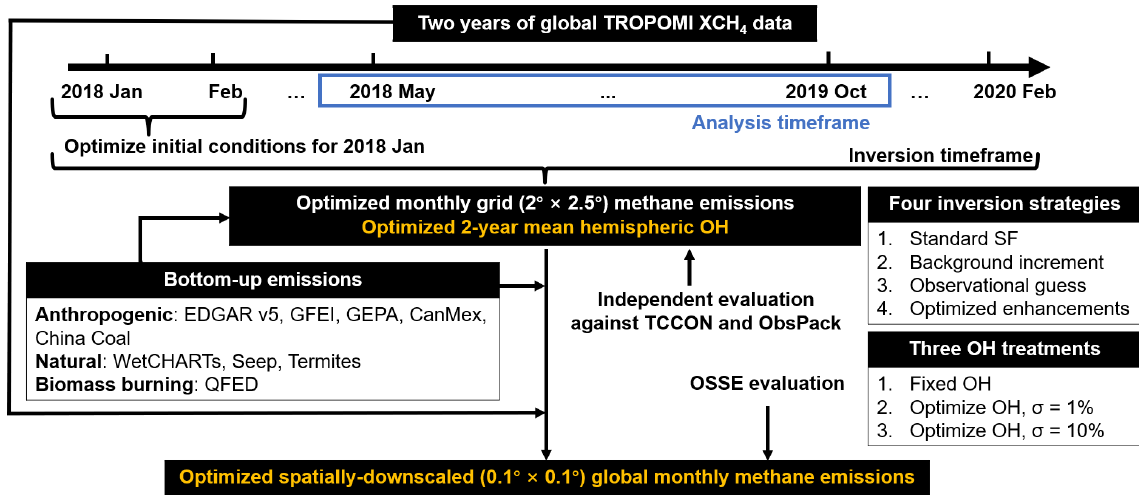
Figure 1. Flowchart showing the TROPOMI methane inversion methodology.